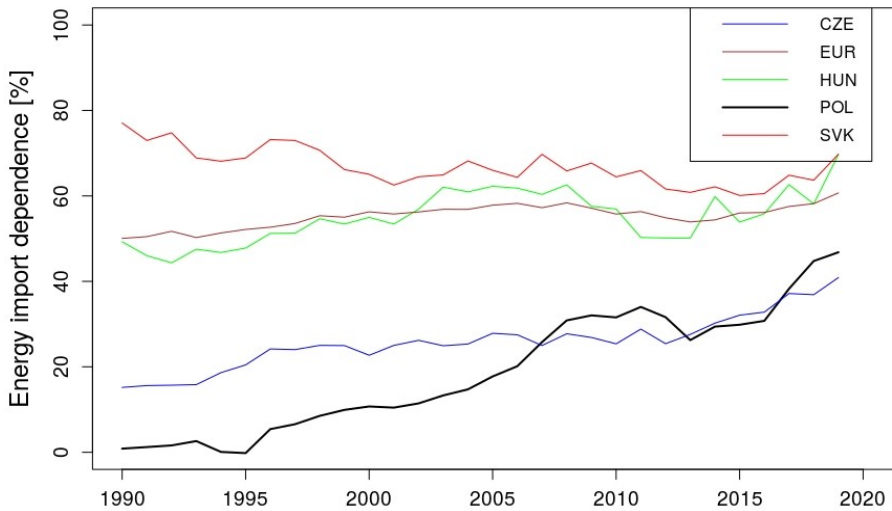
Figure 2. Import dependency (1990–2019). Source: EUROSTAT